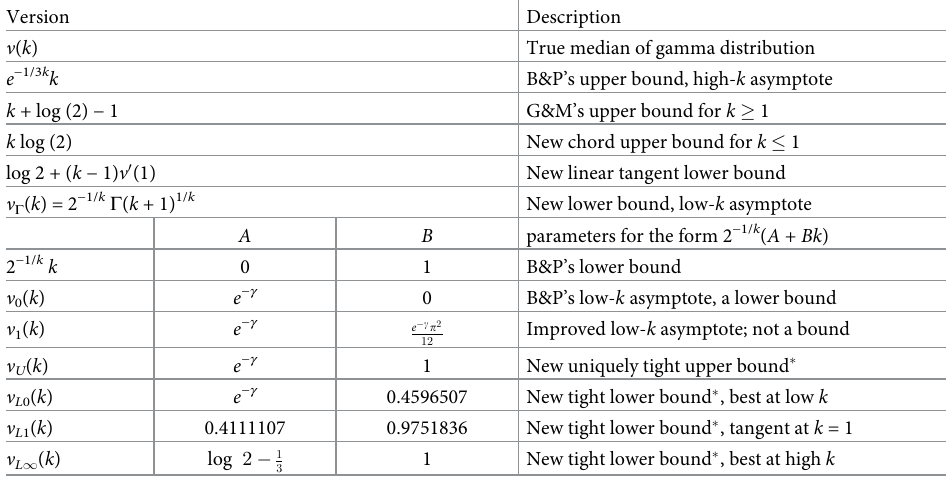
Table 1. Summary of simple bounds and asymptotes.